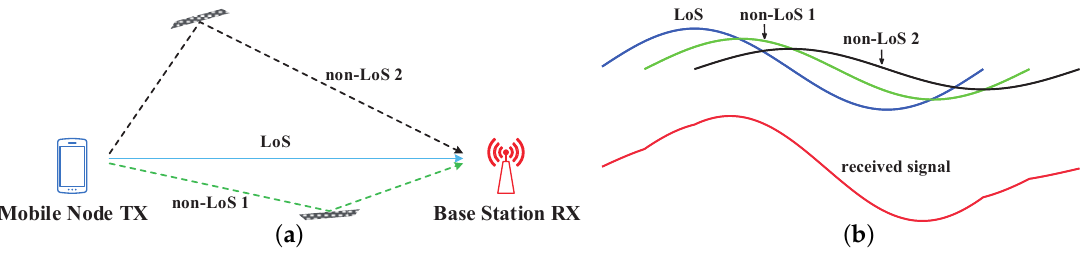
Figure 2. Multipath propagation: ( a ) Signal propagation with the LoS path and two non-LoS paths; ( b ) Actual received signal is a combination of LoS signal and non-LoS